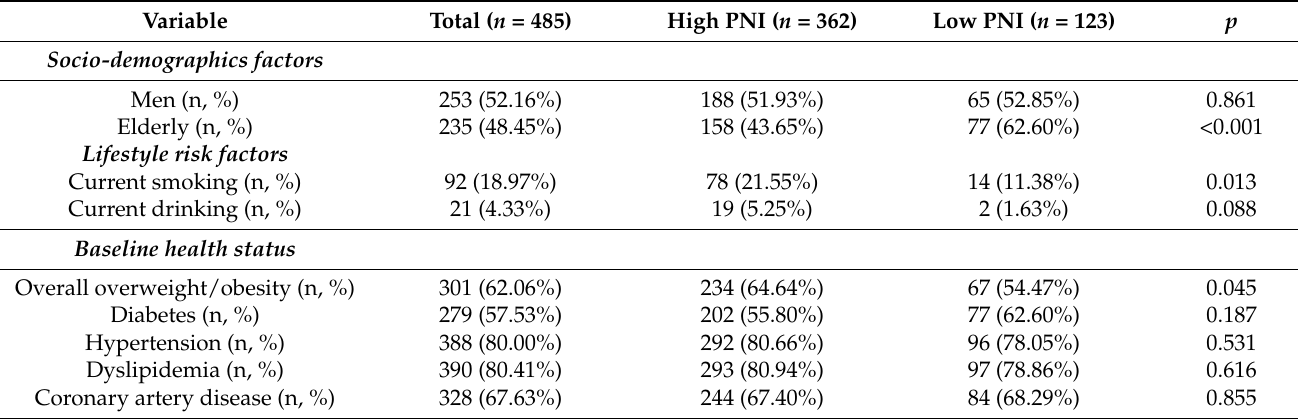
Table 1. Baseline Characteristics of the study